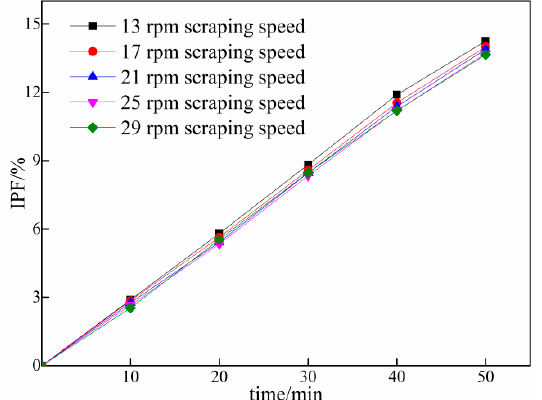
Figure 13. Relationship between IPF and ice-making time at different scraping speeds.